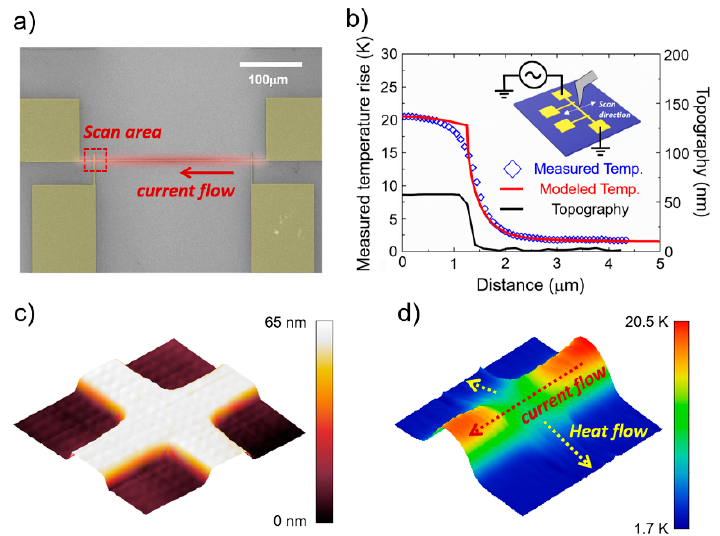
Figure 5. ( a ) SEM image of the fabricated platinum line heater sample. When an electric current is applied to a metal heater, a temperature field is generated around the metal line. ( b ) Graph of the topography and temperature distribution of the metal heater sample according to the distance from the center of the metal line obtained by applying a uniform sinusoidal current to the heater. Black line, blue diamond, and red line represent topography, experimentally measured temperature distribution, and simulated temperature distribution, respectively. Inset shows schematic for the measurement of the temperature distribution of a metal heater. ( c ) Three-dimensional graph of topography obtained by measuring the area marked in ( a ) (10 μ m × 10 μ m). ( d ) Three-dimensional graph of the temperature distribution in the area same as ( c ). Temperature is high on the line through which current flows owing to Joule heating, but on the cross area where two lines cross, the temperature is low because heat escapes to the other line.